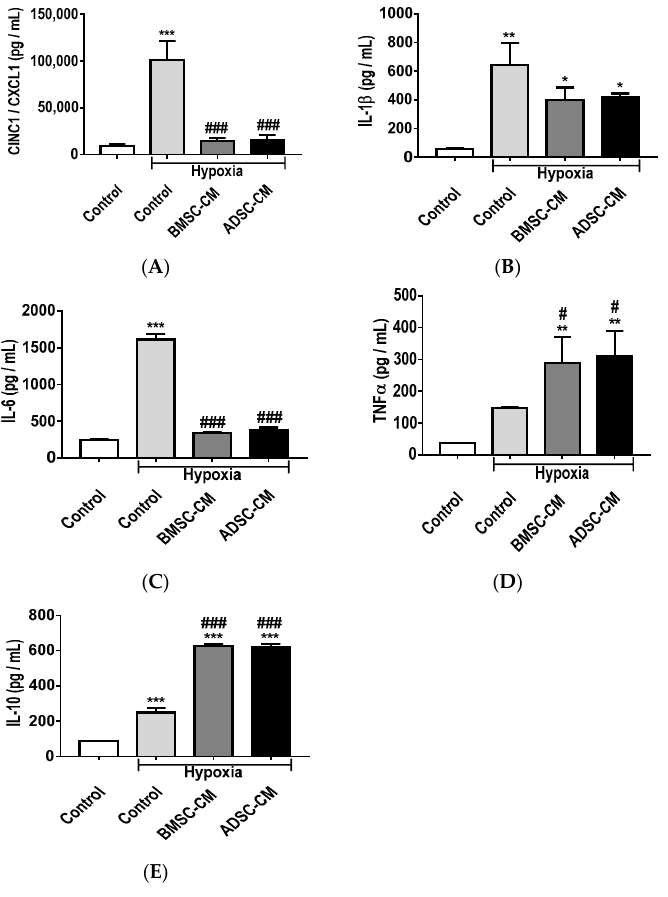
Figure 3. The release of pro-inflammatory; ( A ) CINC-1/CXCL-1, ( B ) IL-1 β , ( C ) IL-6, ( D ) TNF- α and anti-inflammatory cytokines; ( E ) IL-10 from primary rat AECs pre-treated with human BMSC/ADSC-CM during hypoxic (1.5% O 2 ) exposure for 24 h. ELISAs were used to measure secreted inflammatory cytokines in the supernatant of primary AECs. Data presented as mean ± SD; n = 3 (* p < 0.05, ** p < 0.01, *** p < 0.001 vs. normoxia control; and # p < 0.05. ### p < 0.001 vs. hypoxia control). The